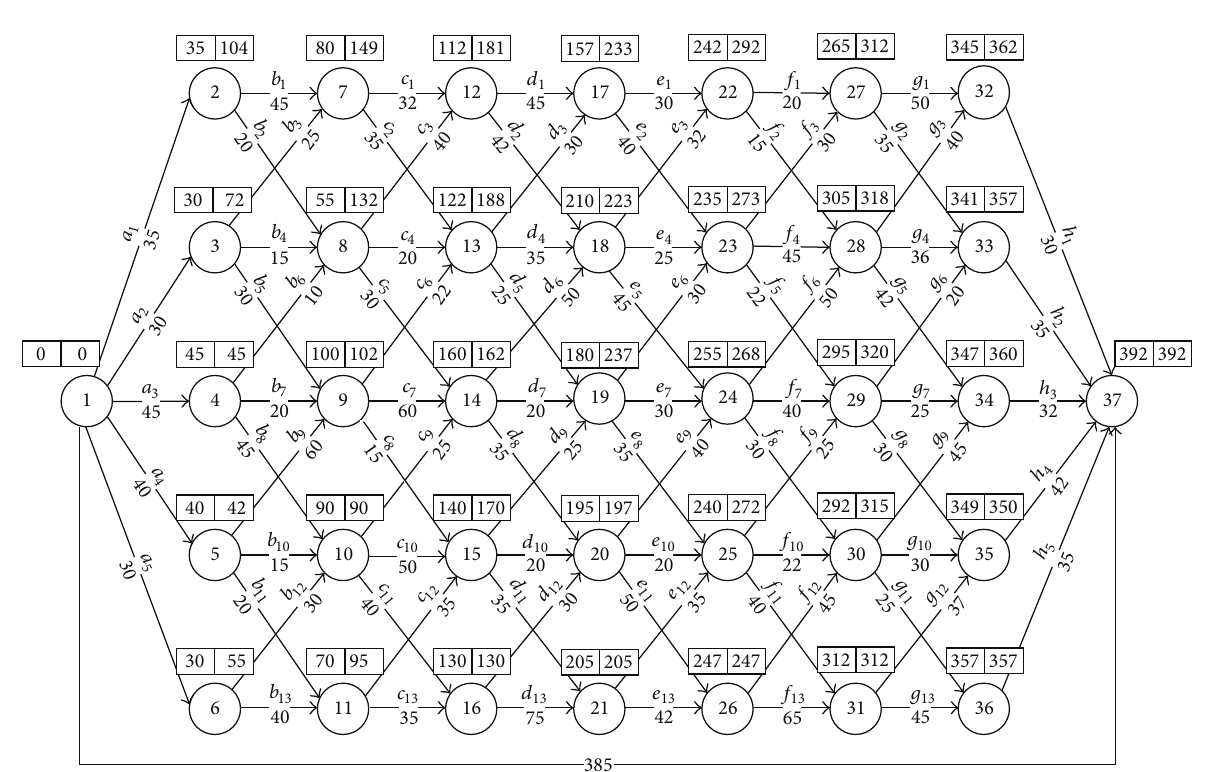
Figure 6: Time parameters for all activities with their remaining longest